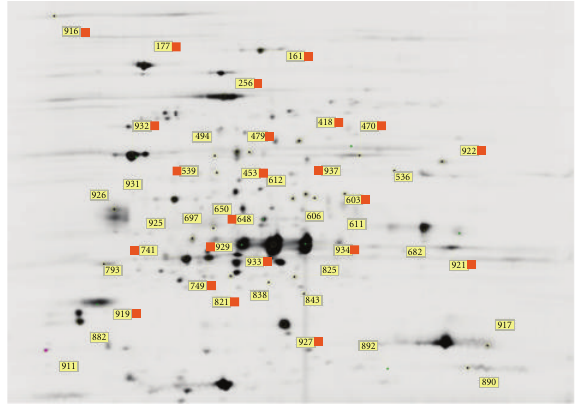
Figure 3: A scanned and cropped 24 cm gel showing annotations for spots selected for further analysis. The spots were selected due to (i) their relative increase or decrease during growth on the selected substrate or (ii) their high abundance in both samples. The spot numbers are identifiers for the quantitative information and identity; identified spots are marked with an orange flag (see Tables 1–3). The approximate pH range (horizontal) is 4–7, and the approximate molecular weight (vertical) is 110 kDa to 10